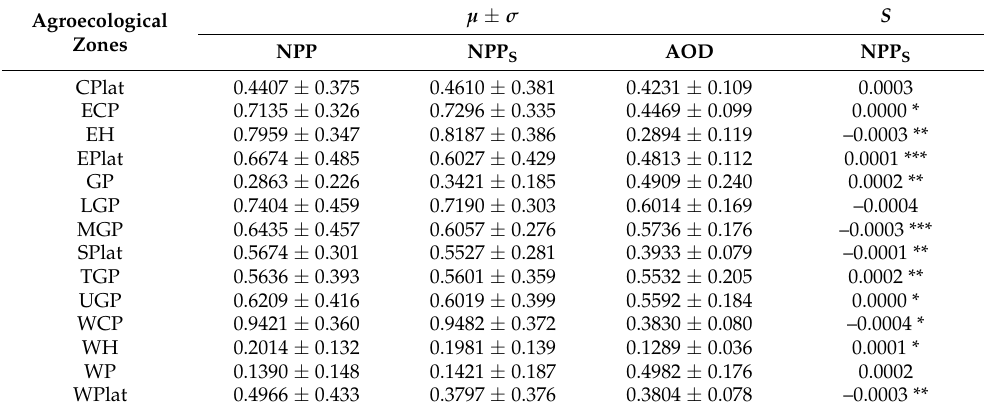
Table 2. Mean ( µ ) and SD ( σ ) of NPP and AOD for the ecological regimes of India from 2001–2020. NPP S signifies the overall mean for the possible sensitive zones of ecological regimes, with S indicat- ing the slope by ITA.